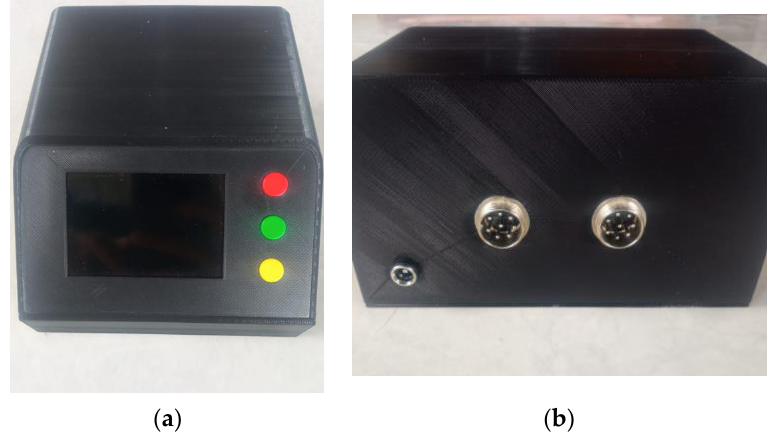
Figure 11. Box hardware ( a ) front view and ( b ) back view.